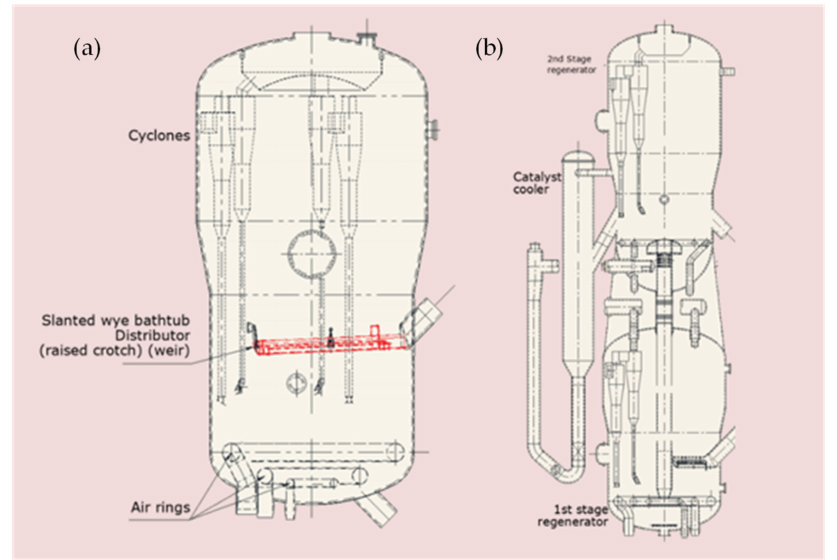
Figure 3. FCC regenerator full combustion designs: ( a ) single-stage regeneraator; ( b ) TechnipFMC two-stage regenerator (adapted from Singh and Gbordzoe